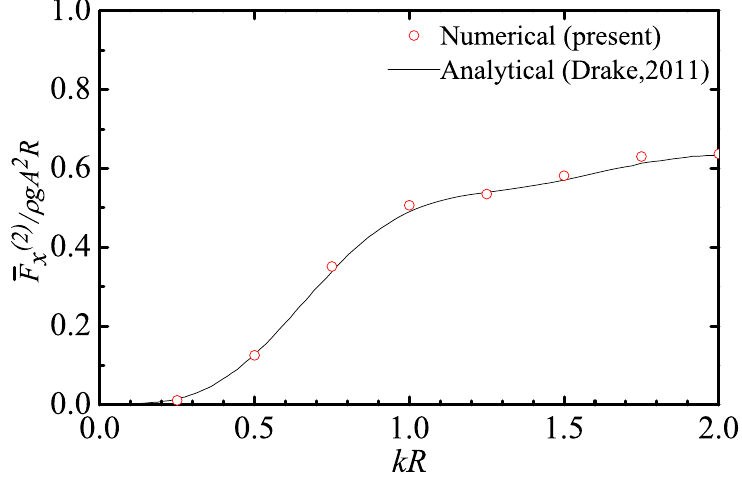
Figure 8. Horizontal wave-drift forces acting on the